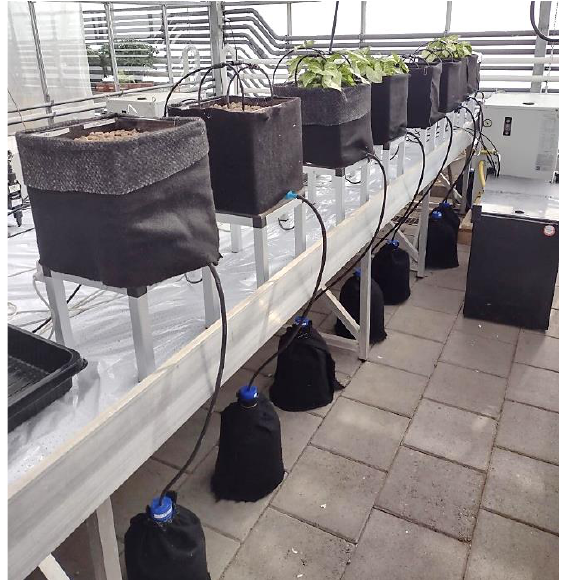
Figure 1. Mesocosm CWH built in the greenhouse of Wageningen University and Research, the Netherlands.